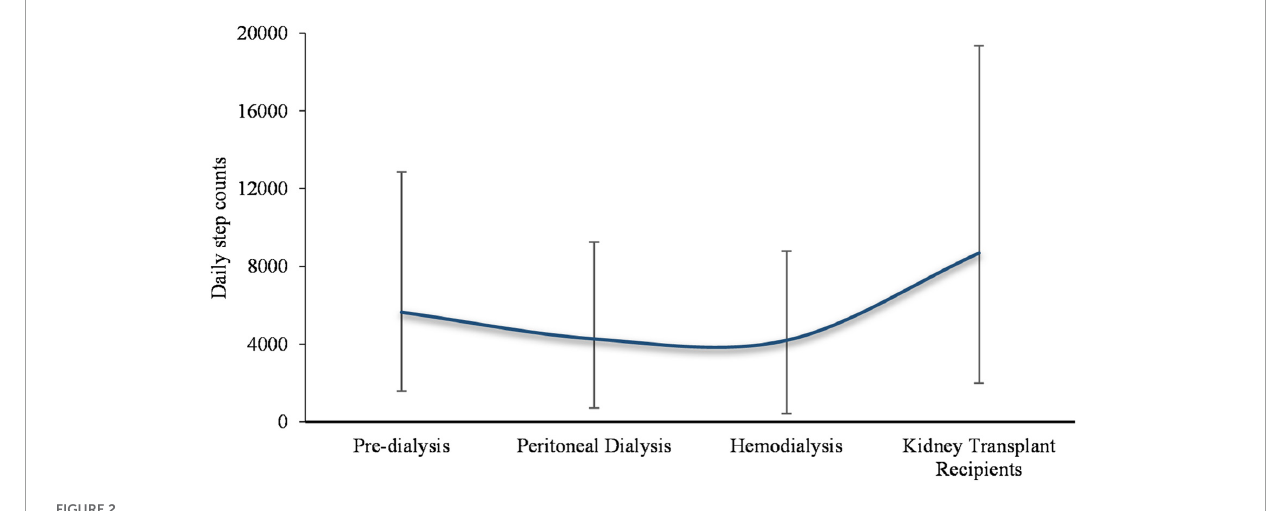
FIGURE2 Daily step-based physical activity in patients with different stages of CKD.